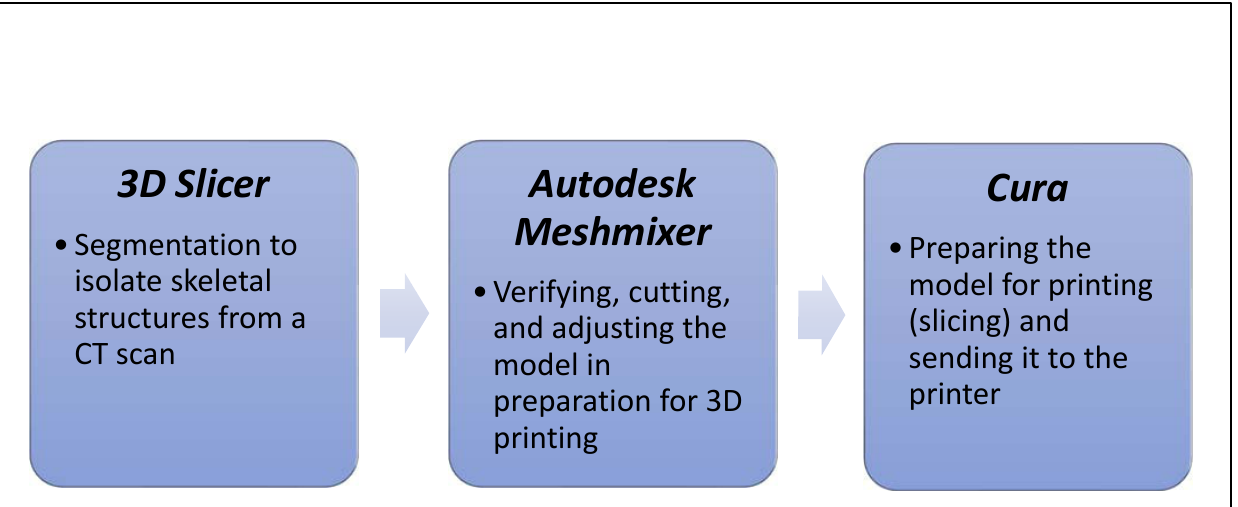
Figure 1. The three main steps and their associated software required to produce an in-house 3-dimensional printed craniofacial model: 3D Slicer v4.11 (Slicer community, http://www.slicer.org). Autodesk MeshMixer v3.5.474 (Autodesk, San Rafael, CA, USA). Slicer for many filament printers: